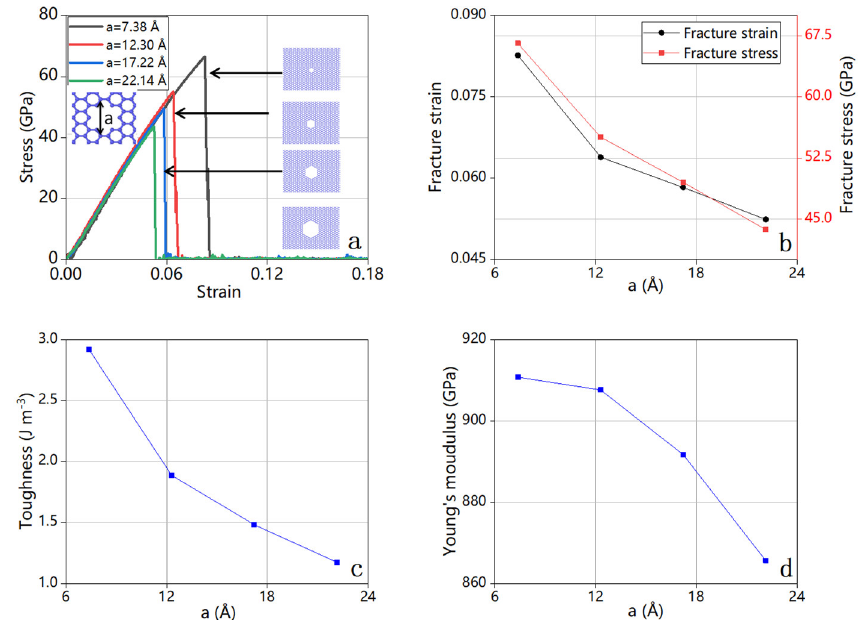
Figure 7. Mechanical properties analysis of bilayer-crack graphene with quasi-hexagonal cracks of different maximum vertex distance a of quasi-hexagon ( a ) Stress–strain relationships ( b ) Fracture strain, ( c ) Fracture stress, ( d ) Young’s modulus. Both Young’s modulus and fracture toughness decayed with the increasing size of the circular crack.